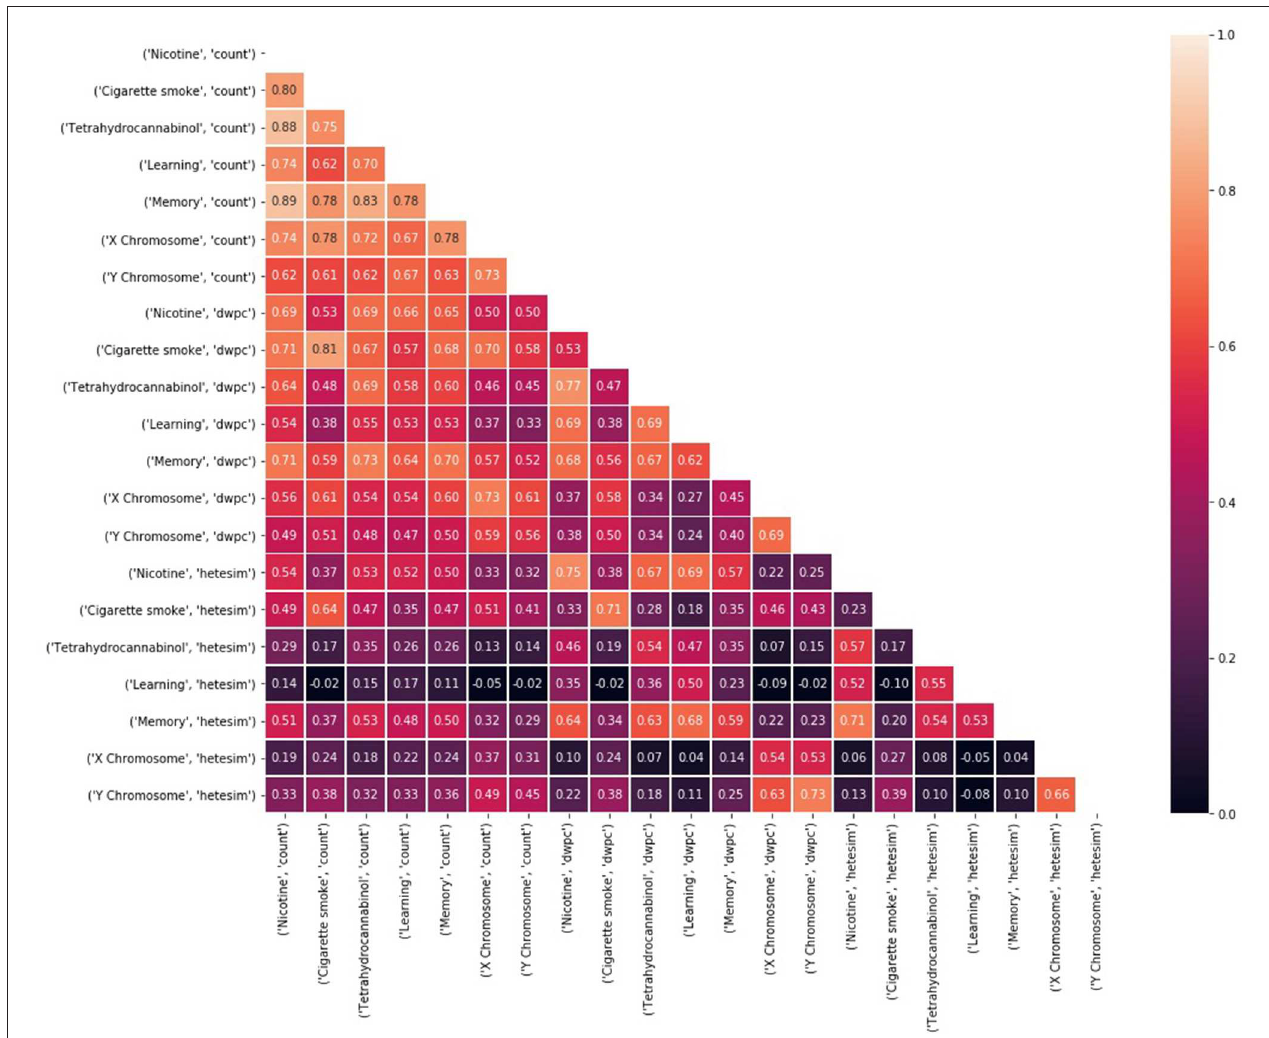
FIGURE 7 | Kendall’s τ rank correlations (Knight, 1966) between rankings of 324 source nodes with respect to each of 21 target node and feature type combinations. Rankings are based on a weighted sum of noisy, feature-based rankings, where weights are learned based on consistent agreement with the average ranking.